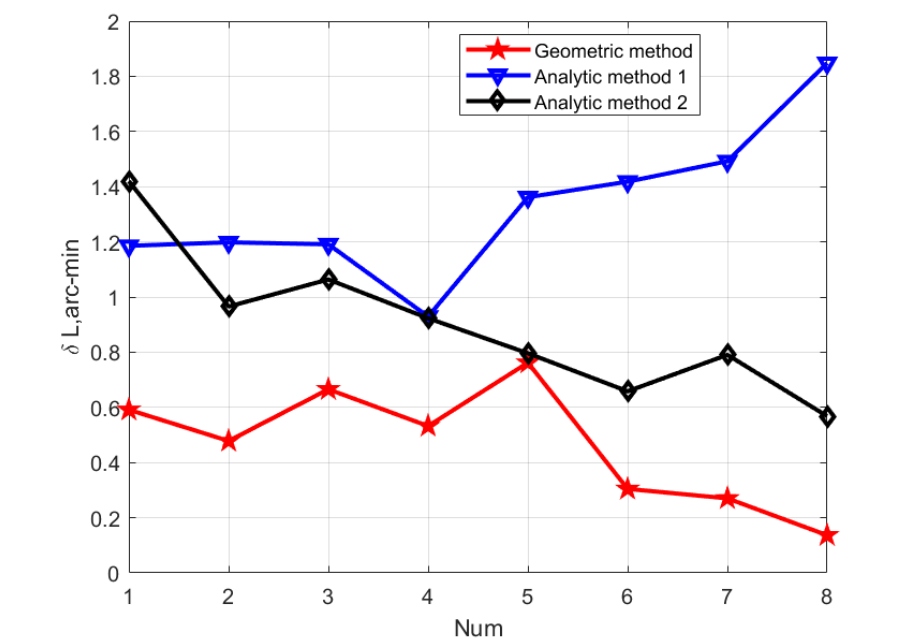
Figure 12. The latitude error curve of real INS for diferent location in